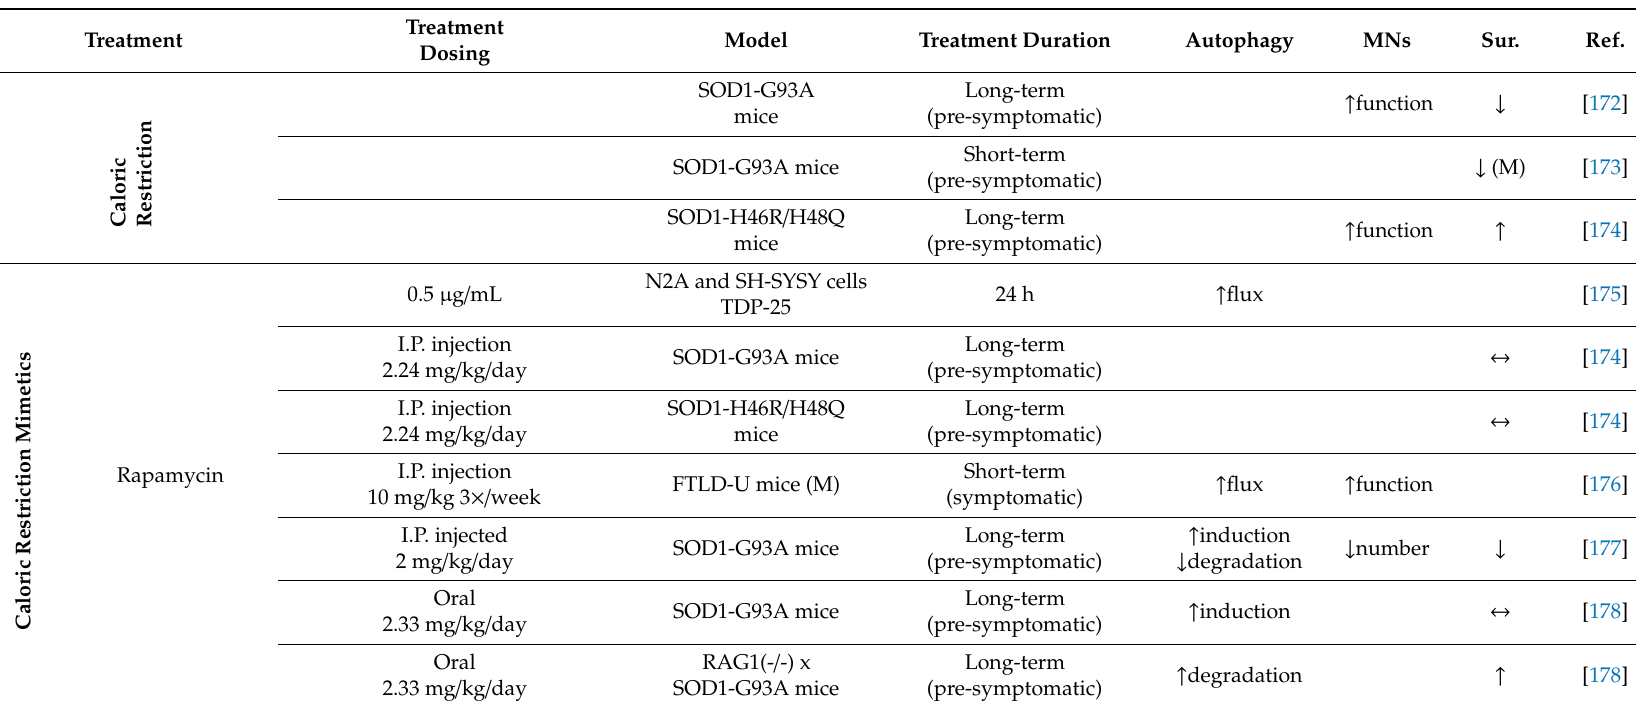
Table 2. The e ff ect of autophagy-targeted treatments on ALS models. Sur., survival; Ref., reference; F, female mice; M, male; ↑ , increased / restoration; ↓ , decreased; ↔ , una ff ected; co, combination of treatments; *, p62 remained